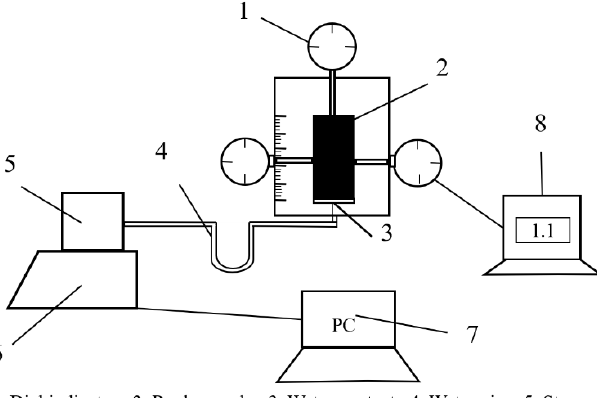
Figure 1. Water absorption test device.